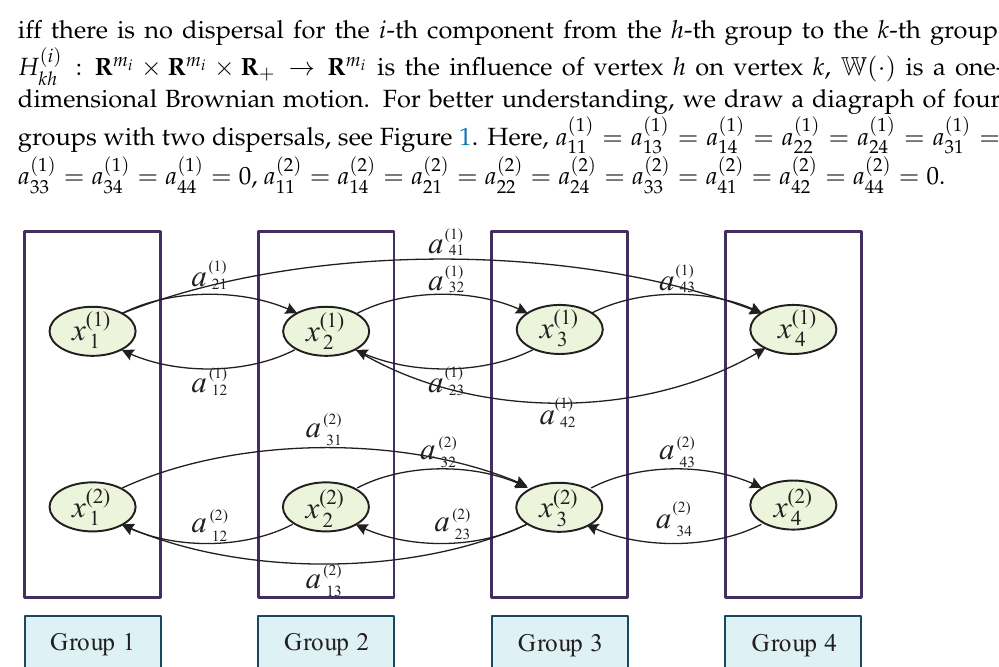
Figure 1. A four-group diagraph for model (1) with two